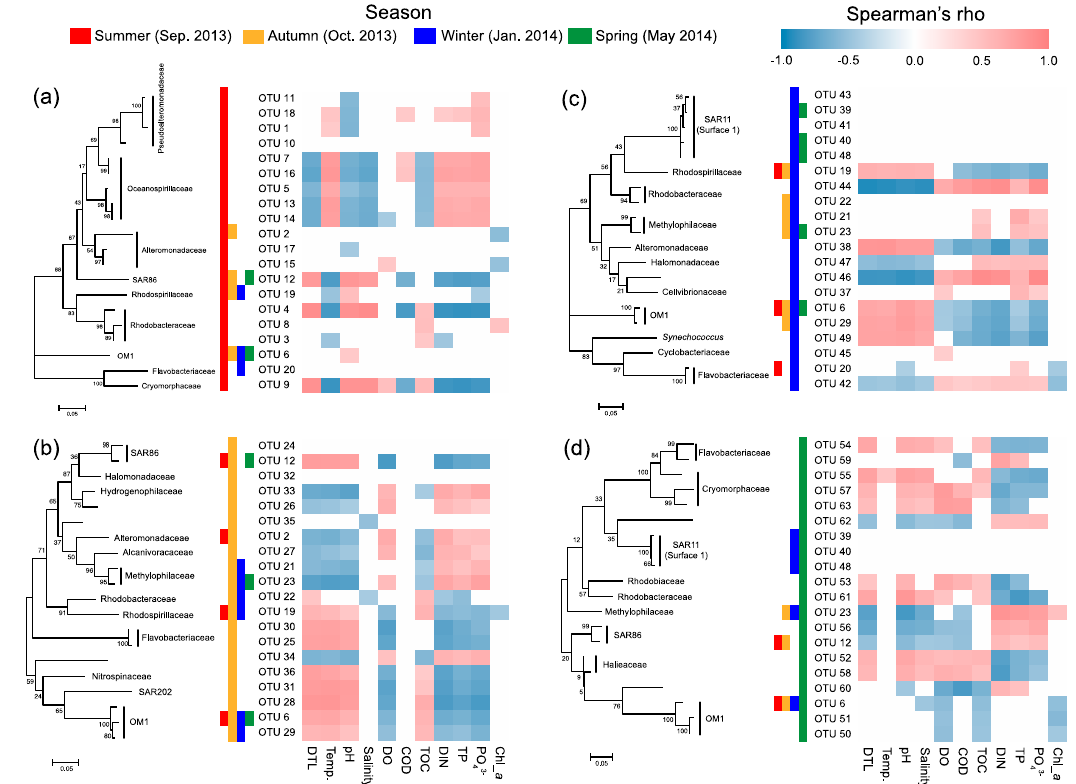
Figure 8. Spearman’s correlations between the top 20 key driver OTUs and environmental factors in the summer ( a ), autumn ( b ), winter ( c ), and spring ( d ). DIN, dissolved inorganic nitrogen; TP, total phosphorus; Temp., water temperature; COD, chemical oxygen demand; DO, dissolved oxygen; TOC, total organic carbon. Chl- a , chlorophyll- a . Colored cells in the heatmaps indicate significant correlations ( p < 0.05).